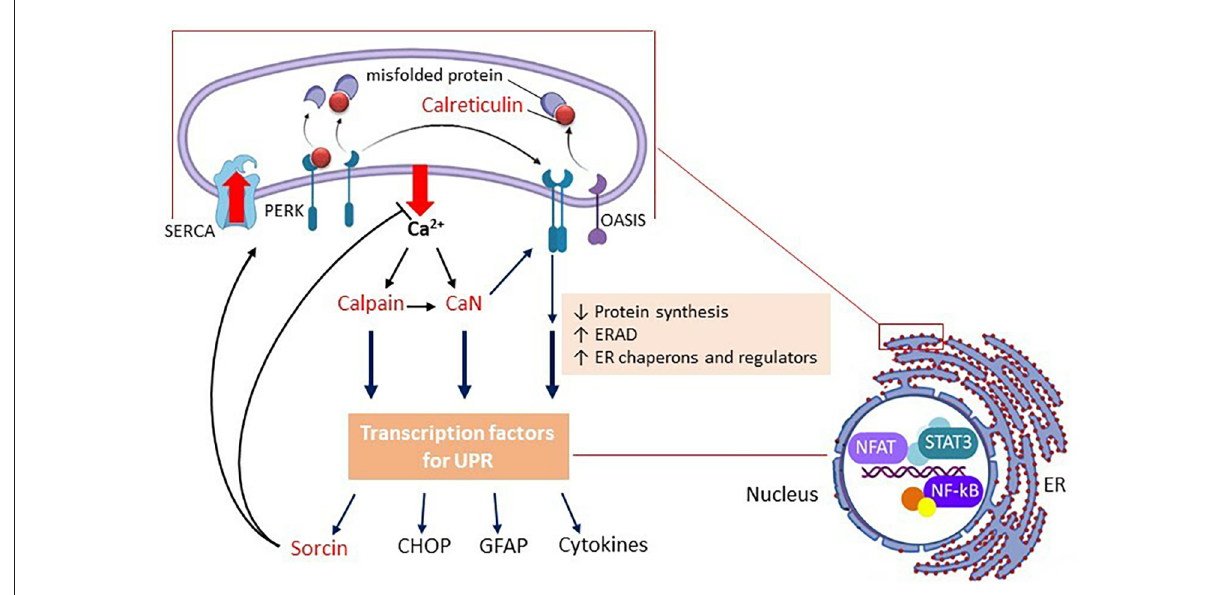
FIGURE1 Schematic representation of the UPR in astrocytes. Only PERK and OASIS are represented as ER stress sensor proteins. Upon Ca 2+ efflux, the chaperone CBPs (e.g., calreticulin) move from the sensor proteins (in the membrane) to the unfolded proteins (in the lumen), promoting the oligomerization of the sensor proteins, and triggering the UPR. In parallel, but not independently, the outgoing Ca 2+ activates calpain and calcineurin (CaN). CBPs are all represented in red. Note that CaN (independent of enzyme activity) positively modulates PERK. Gene expression in the UPR, in general, is reduced, but some modulating proteins are upregulated, such as sorcin, CHOP, and GFAP, in addition to pro-inflammatory cytokines. Sorcin plays a role at the beginning of the UPR (negatively modulating Ca 2+ efflux and CHOP expression). CHOP will play an important role in cell death if the triggering factor(s) of the UPR persist. It is important to mention that calpain and CaN modulate ER Ca 2+ -channels and SERCA, but in this scheme, only sorcin, which also plays this role, is highlighted. The image on the right emphasizes the structural relationship and bidirectional communication between the ER and the nucleus, where the main transcription factors of the astroglial inflammatory response (NF-kB, NFAT, and STAT) are highlighted. Abbreviations: CaN, calcineurin; CBP, calcium-binding protein; CHOP, CCAAT-enhancer-binding protein homologous protein; ERAD, ER-associated degradation; GFAP, glial fibrillary acidic protein; NF-kB, nuclear factor kappa B; NFAT, nuclear factor of activated T-cells; OASIS, old astrocyte specifically induced substance; PERK, protein kinase R-like ER kinase PERK; SERCA, sarco/endoplasmic reticulum Ca 2+ -ATPase; STAT, signal transducer and activator of